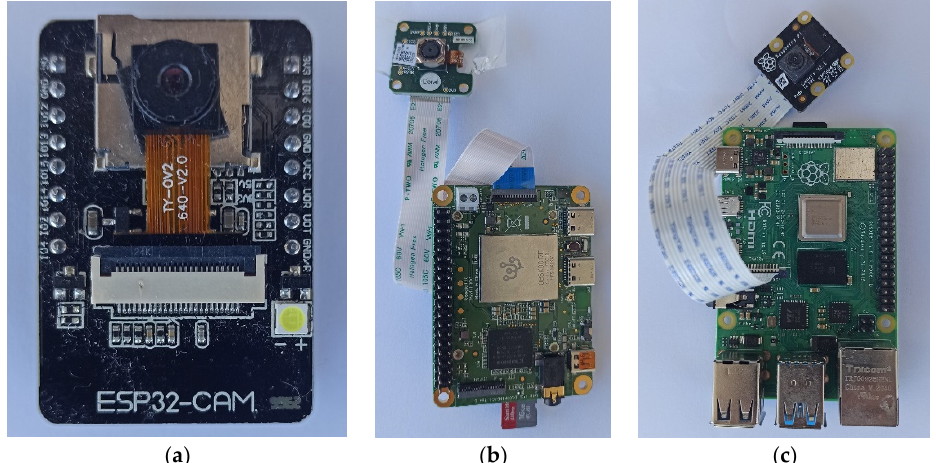
Figure 1. ( a ) The ESP32-CAM-based device, ( b ) the Coral-based device, and ( c ) the Raspberry Pi4 device.